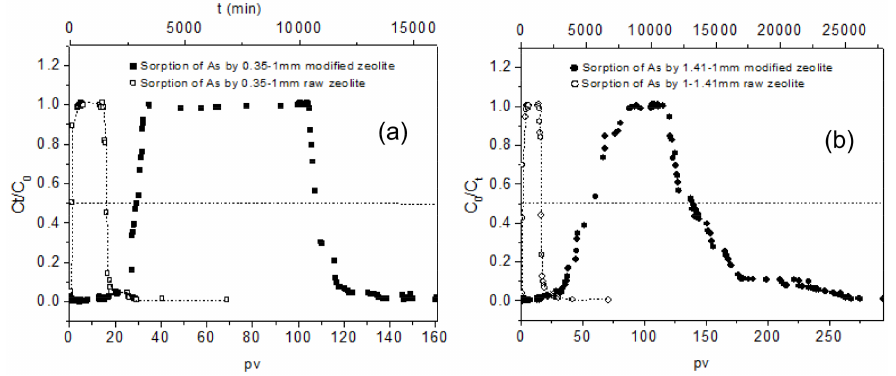
Figure 6. Arsenic transport through zeolite and ILMZ of different particle sizes. ( a ) 0.35–1.0 mm ranges; ( b ) 1.0–1.41 mm ranges.